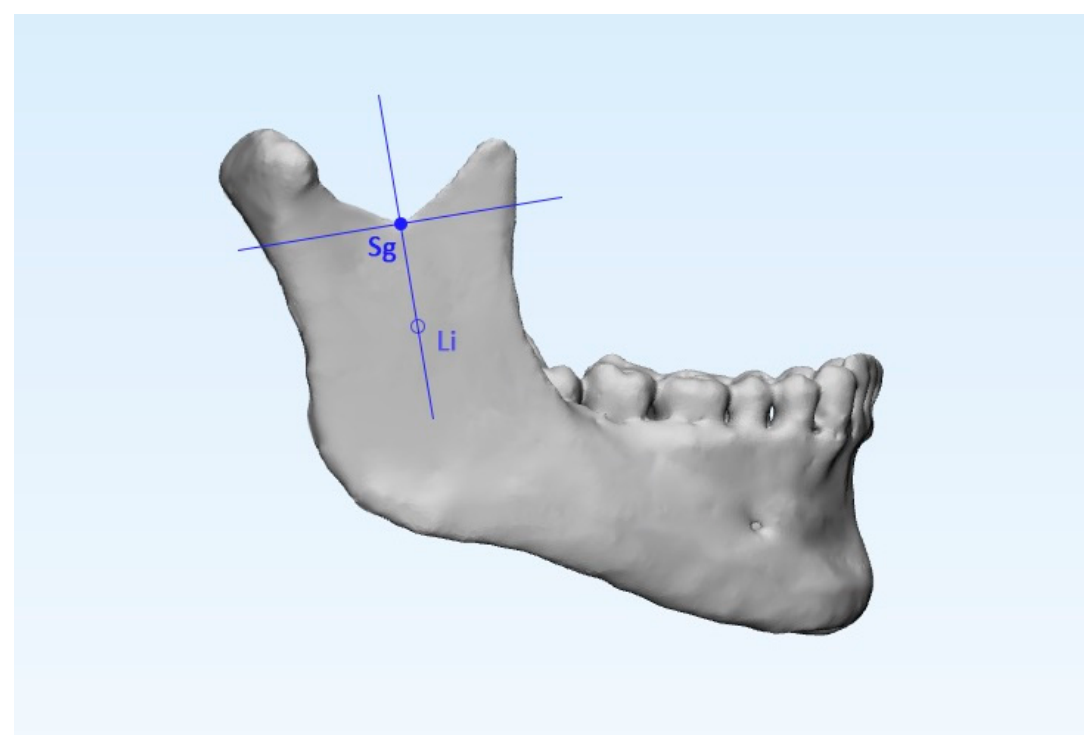
Figure 3. The sigmoid point (Sg) and the point representing the external projection of the lingual (Li) were used to generate two plane cuts, respectively, the Sg-Li plane and a perpendicular plane passing through Sg (90° with respect to the Sg-Li). These two planes were used to delineate the condylar region.